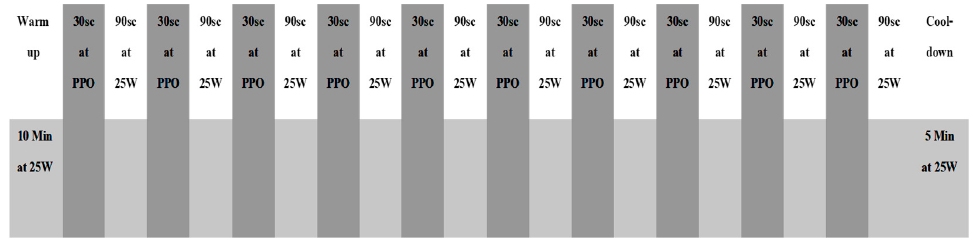
Figure 1. Training program protocol, including warm-up and